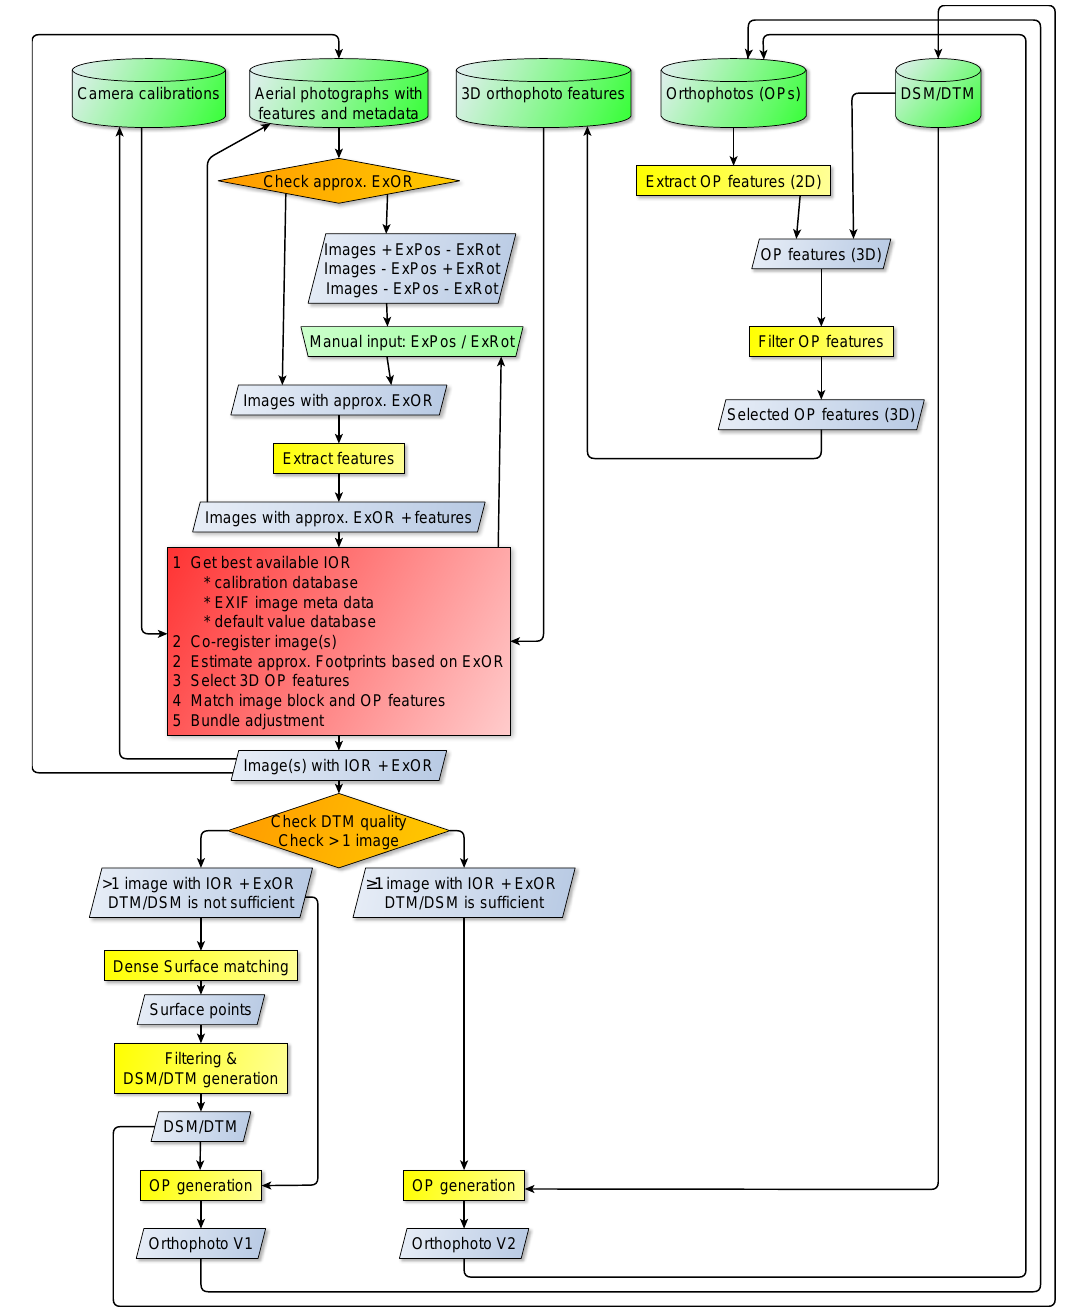
Figure 2: Flowchart of all processing steps needed for automatic orthophoto